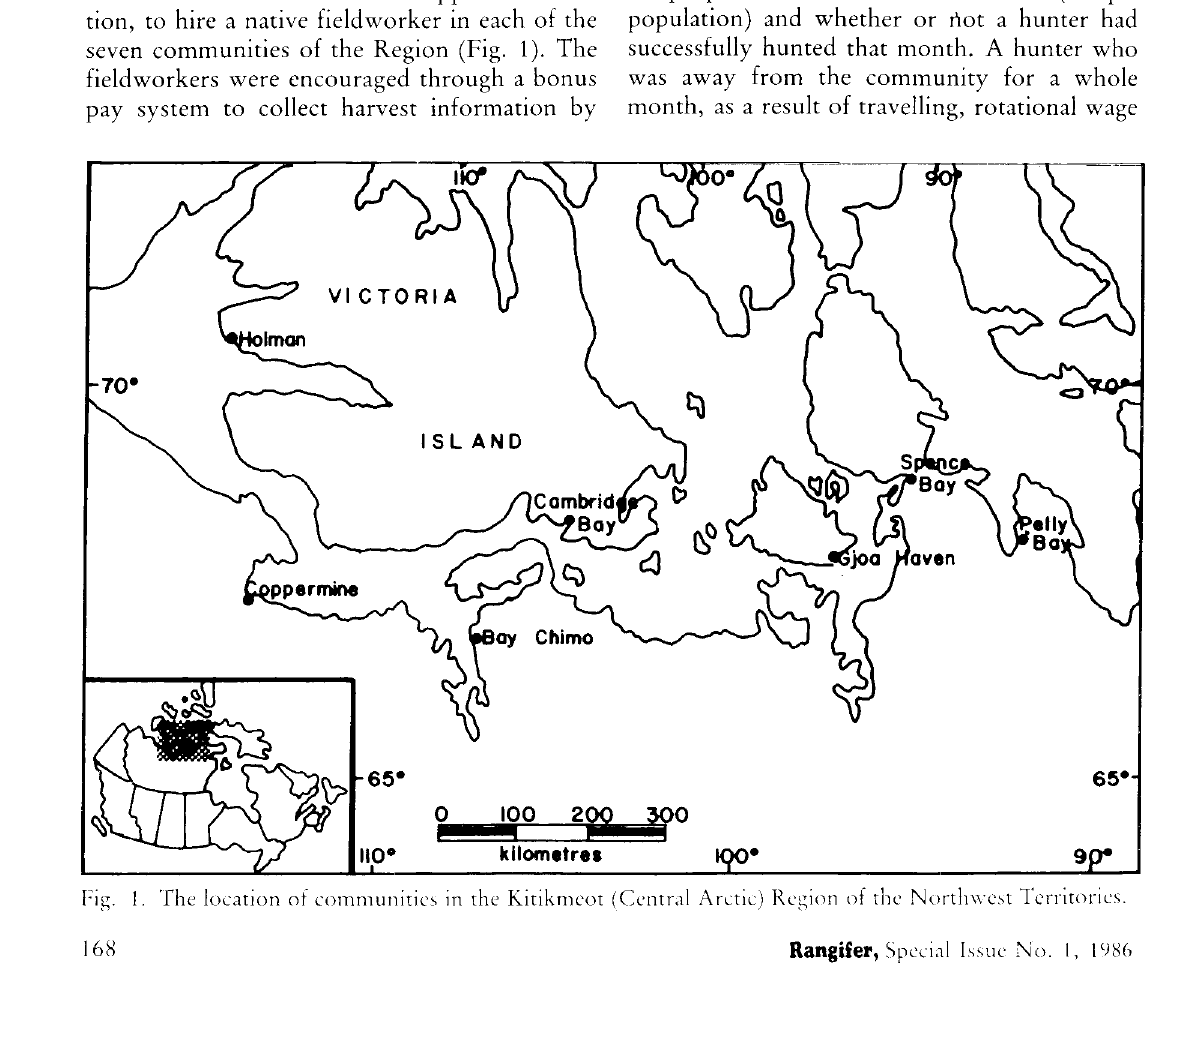
Fig. 1. The location of communities in the Kitikmeot (Central Arctic) Region of the Northwest Territories.